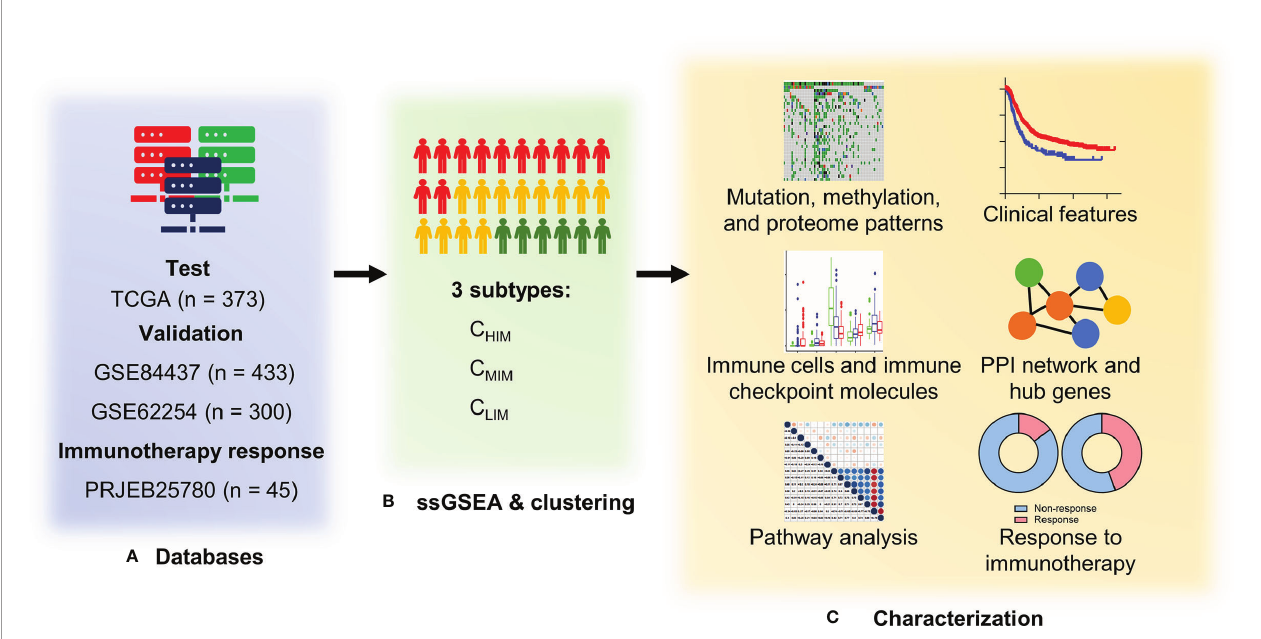
FIGURE 1 | Study design and work fl ow of the present study. (A) Four databases of gastric cancer sequencing or gene array data were used as test and validation cohorts. (B) RNA expression data were quanti fi ed with 29 immune signatures by single-sample Gene Set Enrichment Analysis (ssGSEA) and hierarchically clustered into three subtypes. (C) Clinical features, genetic and epigenetic patterns, immune characteristics, and enriched pathways were compared among the three subtypes. In addition, an association between subtypes and responses to immunotherapy (pembrolizumab) was evaluated in the PRJEB25780